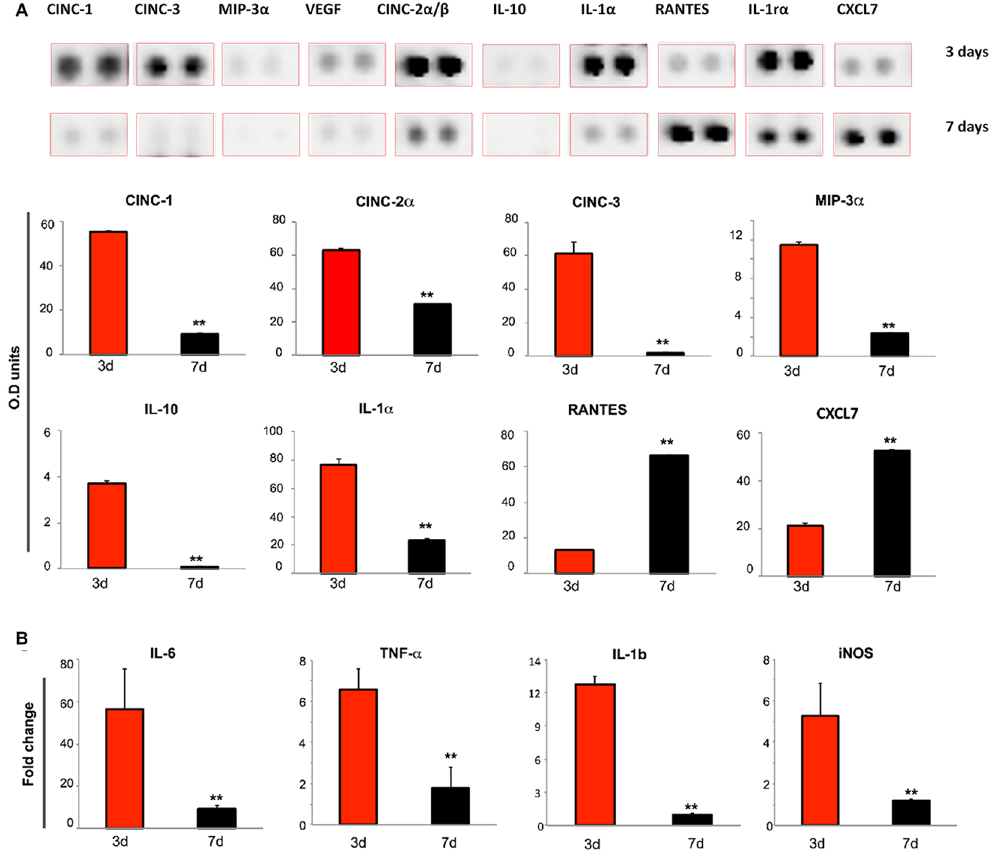
Figure 5. Inflammatory proteins expression induced by CSCL. ( A ) Differences in the rat cytokines/chemokines profiling of CSCL at 3 days and 7 days. Proteins adsorbed on CSCL surface were extracted. Proteins with different levels of abundance at 3 and 7 days are represented. Bar graph presents mean densitometry units of each spot. Values are presented as the mean ± SD. ( B ) Quantitative PCR analysis for the pro-inflammatory ( Il-6, Tnf- α Il-1 β , iNos)- associated markers at 3 and 7 days from CSCL implants. Expression levels normalized to the reference gene ( Gapdh ). Data are represented as fold-change compared with expression observed in subcutaneous tissues explanted from rats in absence of inflammation. Values are mean ± SD (n = 3). Asterisks depict significant differences between 3 and 7 days ( ** p <